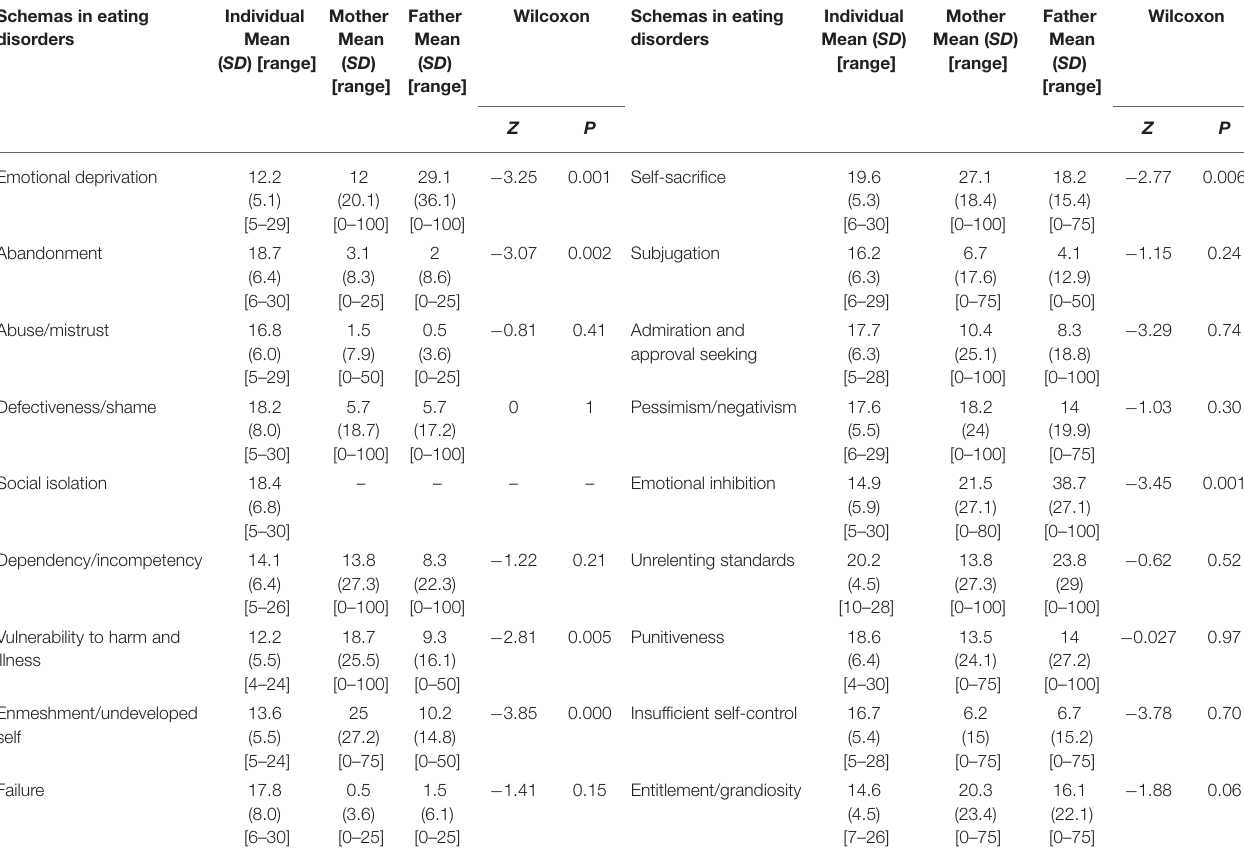
TABLE 2 | Means and SD in individual and parental schemas in eating disorders are